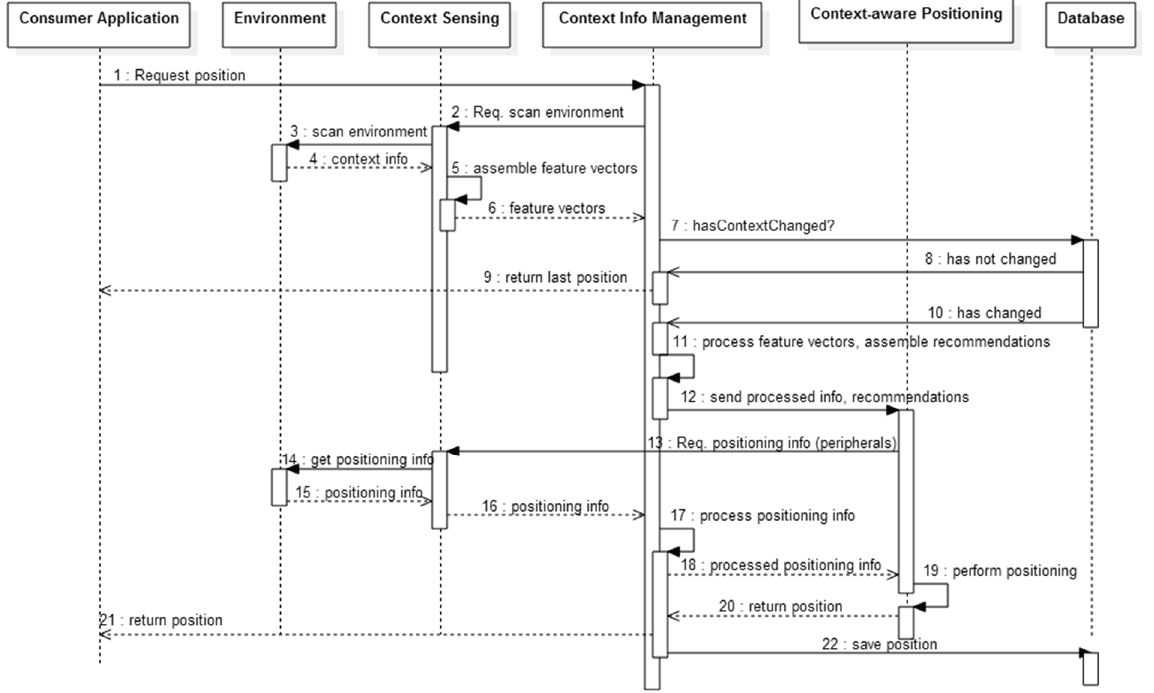
Figure 2. UML sequence diagram of the model’s